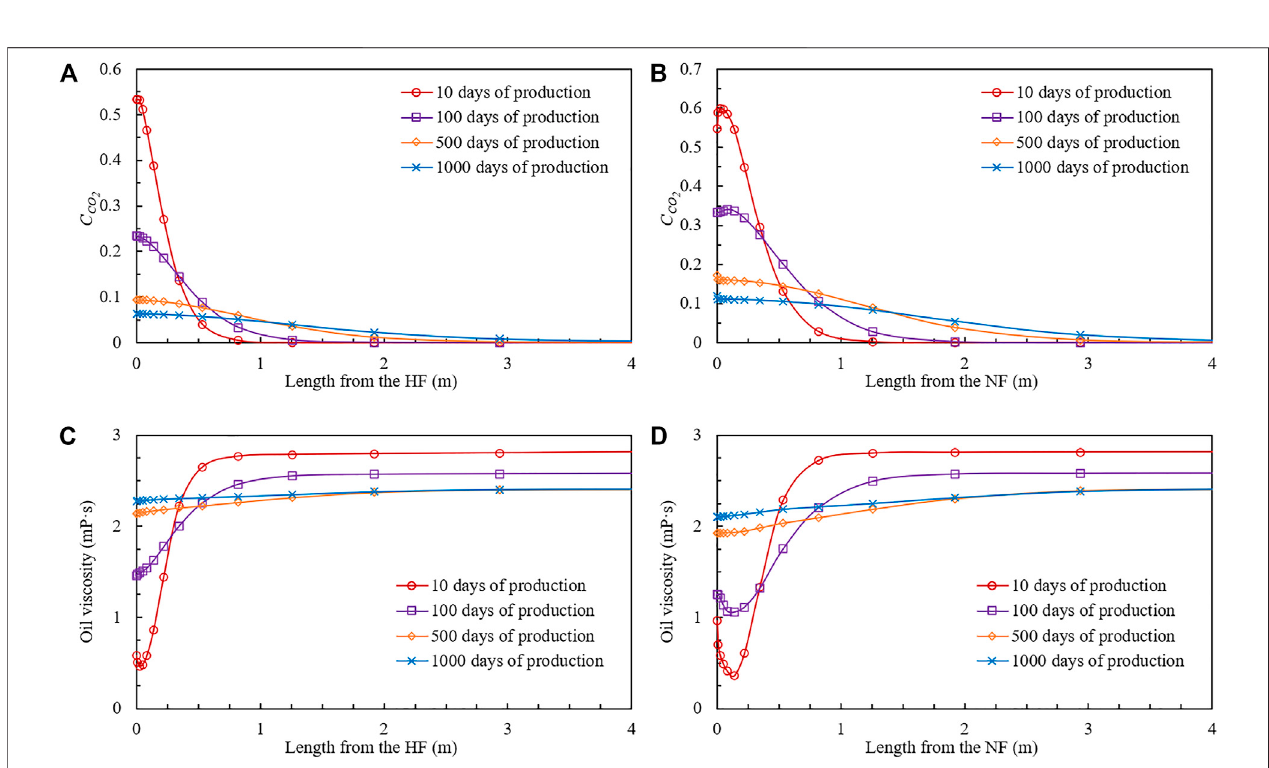
FIGURE 8 | Mole concentration distribution of CO 2 in from HF (A) and NF (B) and viscosity distribution of oil in from HF (C) and NF (D) .